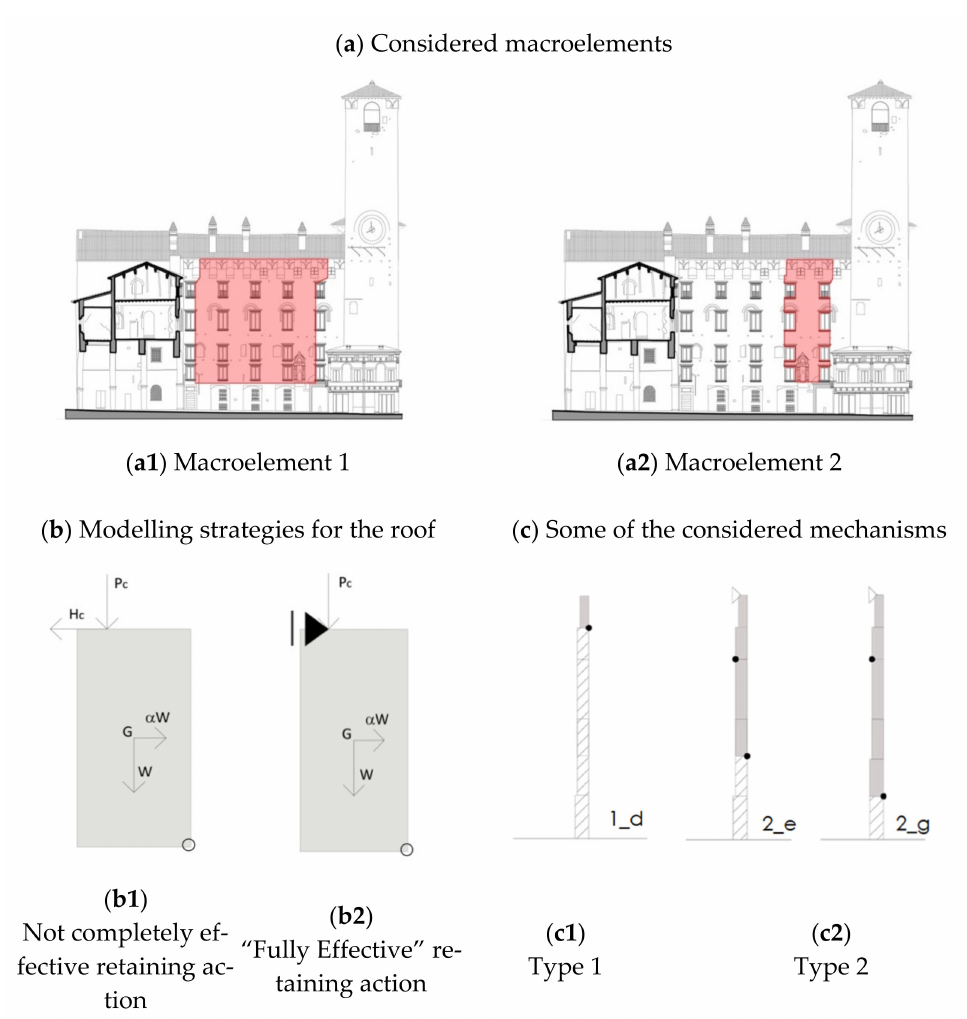
Figure 6. ( a ) Macroelements considered in the analyses; ( b ) different assumptions and corresponding modelling strategies for the roof action; ( c ) corresponding considered mechanisms (for Macroelement 2). Please refer to [32] for the abacus of all the considered